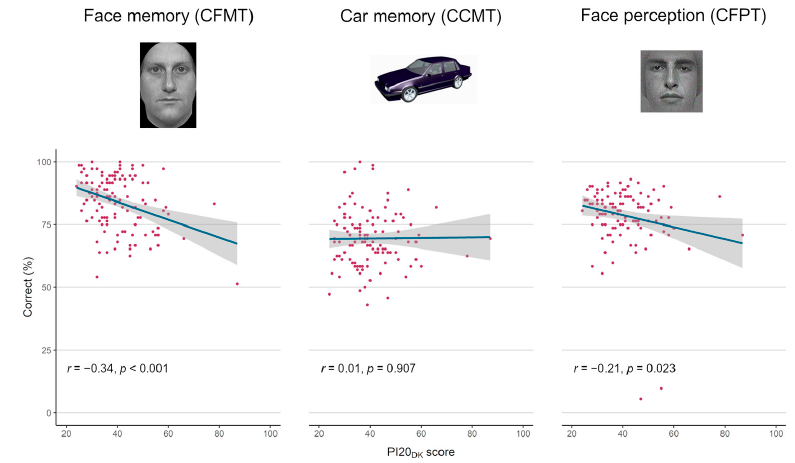
Figure 1. Scatter plots of scores on the PI20 DK and performance on the three objective measures ( N = 119). The blue lines are linear regression models with 95% confidence intervals in grey. PI20 DK = the Danish version of the 20-item prosopagnosia index; CFMT = Cambridge Face Memory Test; CCMT = Cambridge Car Memory Test; CFPT = Cambridge Face Perception Test. The two extreme outliers on CFPT have been kept in the analysis, as specified in the preregistration. If these two points are excluded from the analysis, the result is r = − 0.167 , p = 0.072. Cronbach’s alpha values for PI20 DK , CFMT, CCMT and CFPT (upright trials) were all in the 0.81–0.90 range (see Table 2). The 20 item-total correlations were all significantly larger than zero (Table 3). Table 2. Internal consistency of PI20 DK , CFMT and CCMT (N = 119).